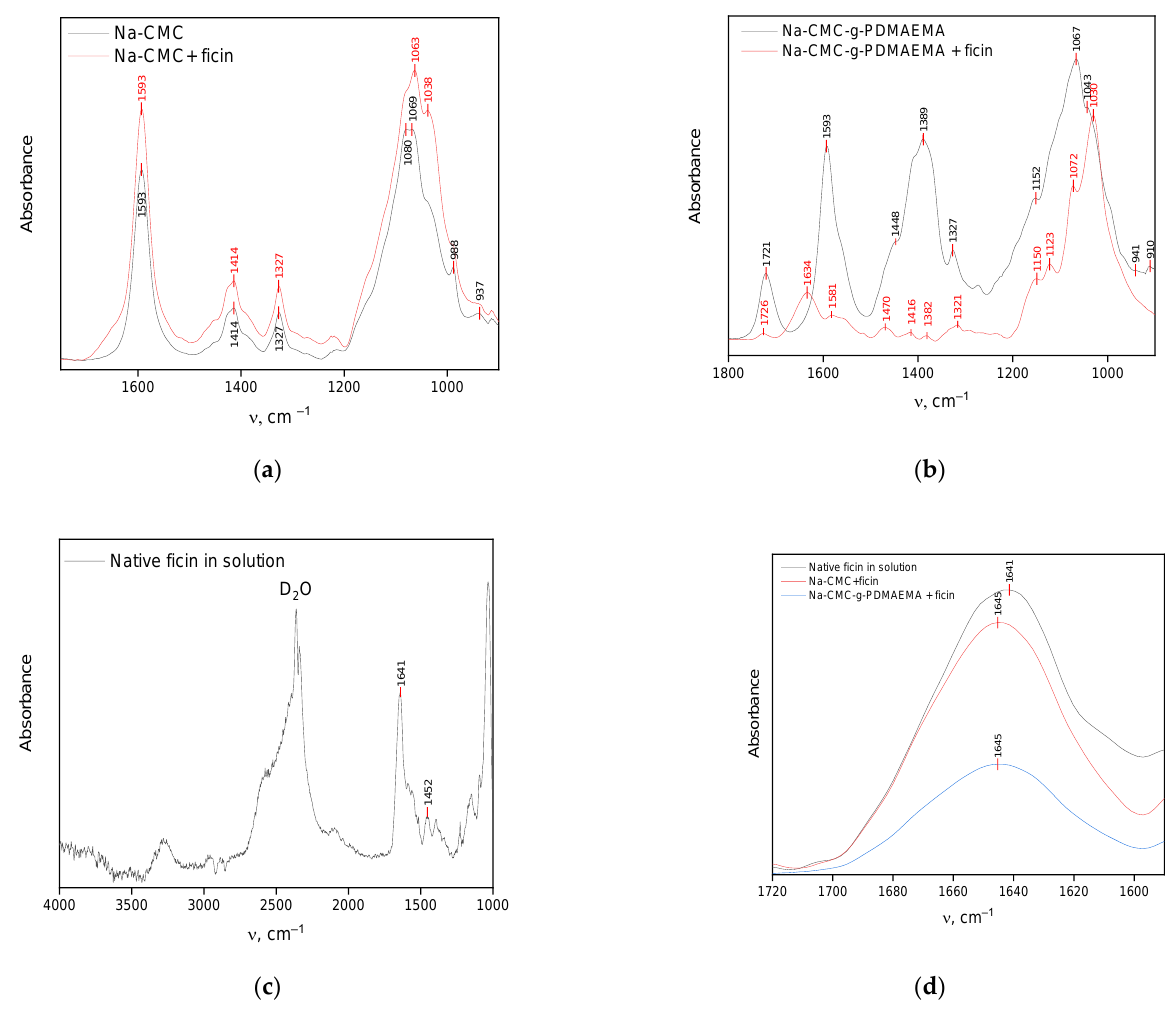
OH-groups and carbon skeleton of the Na-CMC macromolecules in the interactions with the enzyme, which loses the structure of the polysaccharide.